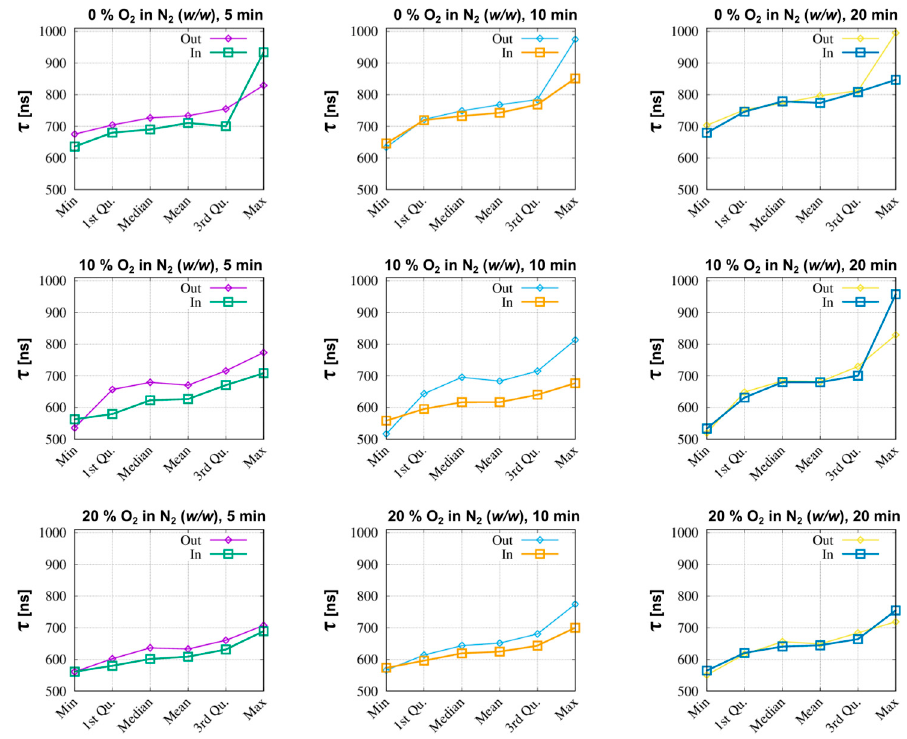
Figure 2. Statistical summaries of the [Ru(Phen) 3 ] 2+ luminescence lifetime measurements analysis in the CAM at 5, 10, and 20 min after iv administration and in atmospheres of 0%, 10%, and 20% O 2 in N 2 ( w / w